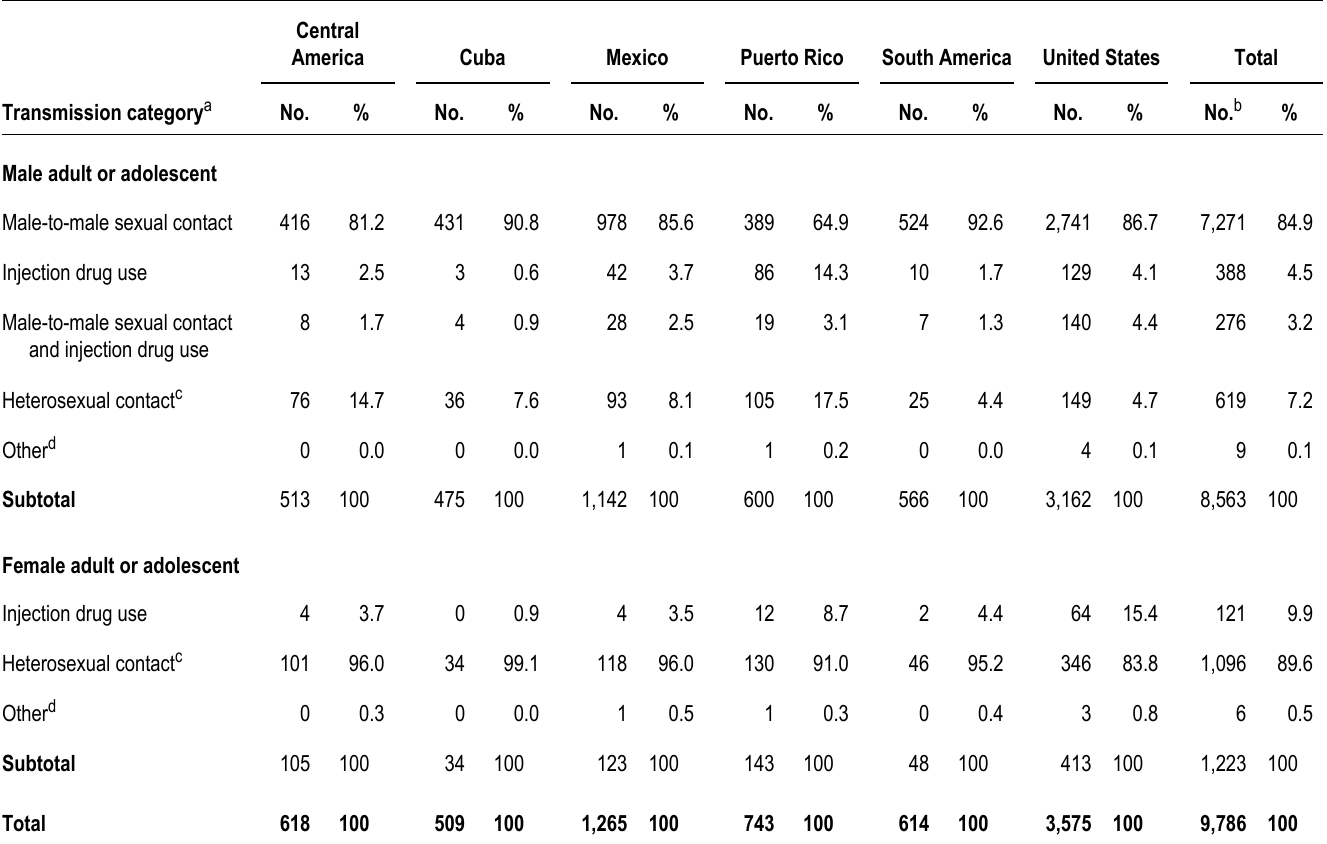
Table 10. Diagnoses of HIV infection among adult and adolescent Hispanics/Latinos, by transmission category and place of birth, 2015—United States and 6 dependent